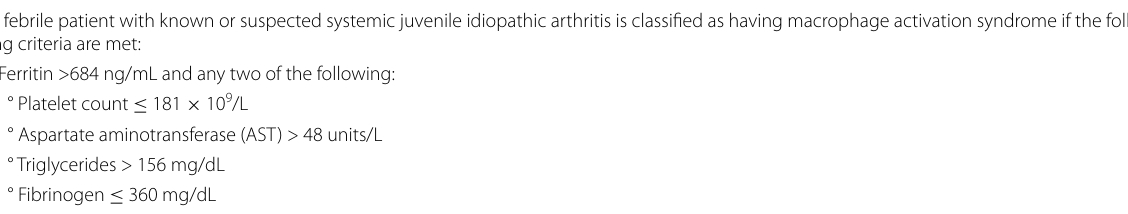
AST aspartate aminotransferase, MAS macrophage activation syndrome